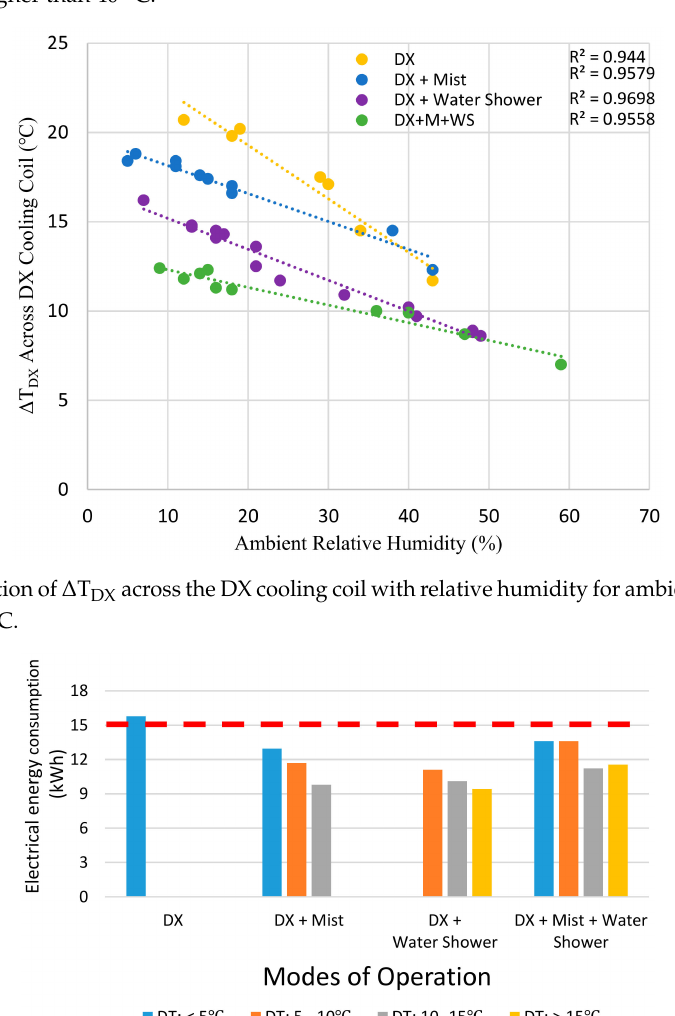
Figure 11. Variation of ∆ T DX across the DX cooling coil with dry-bulb temperature for ambient temperatures higher than 40 ◦ C.